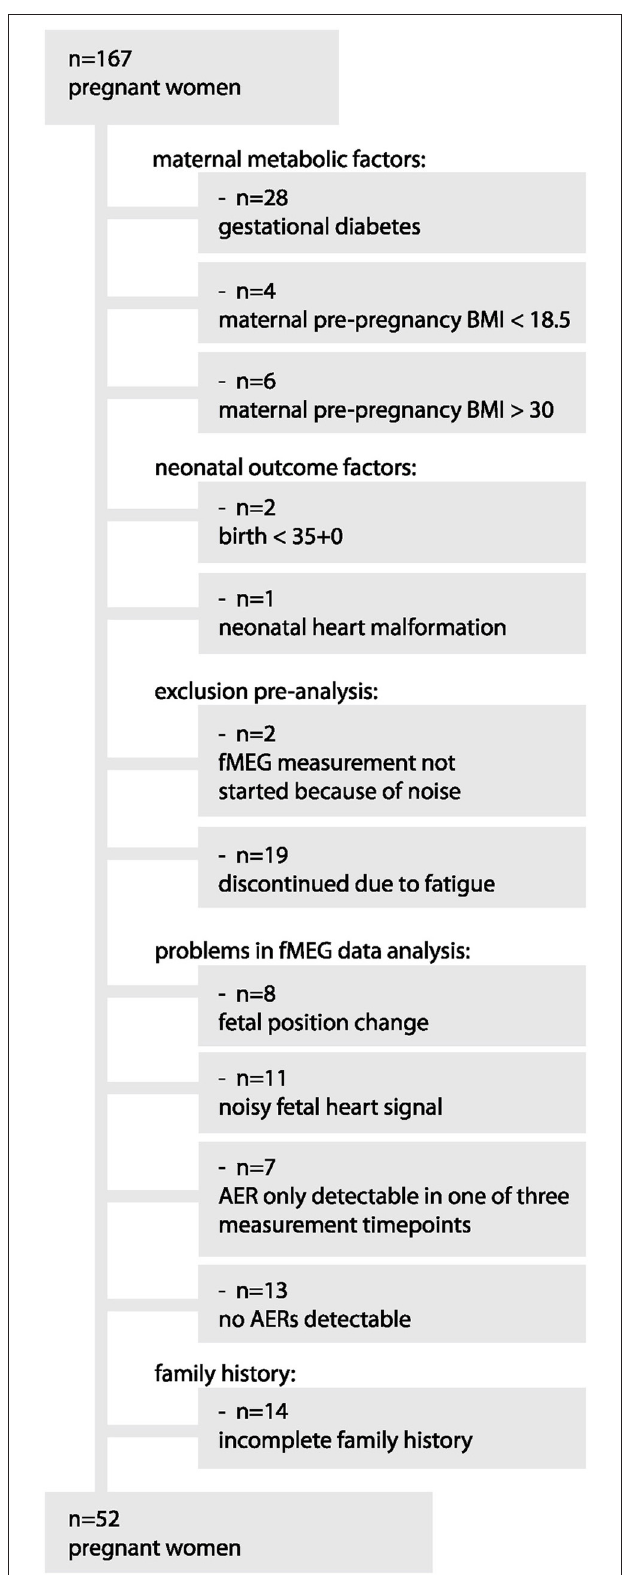
FIGURE 1 | Exclusion process from original sample to final subsample.